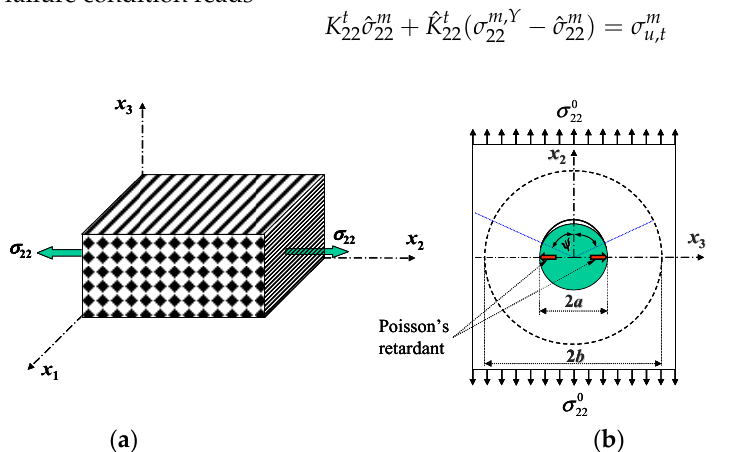
Figure 6. Schematic of ( a ) UD composite subjected to a transverse tension, and ( b ) stable interface debonding due to Poisson’s retardant.